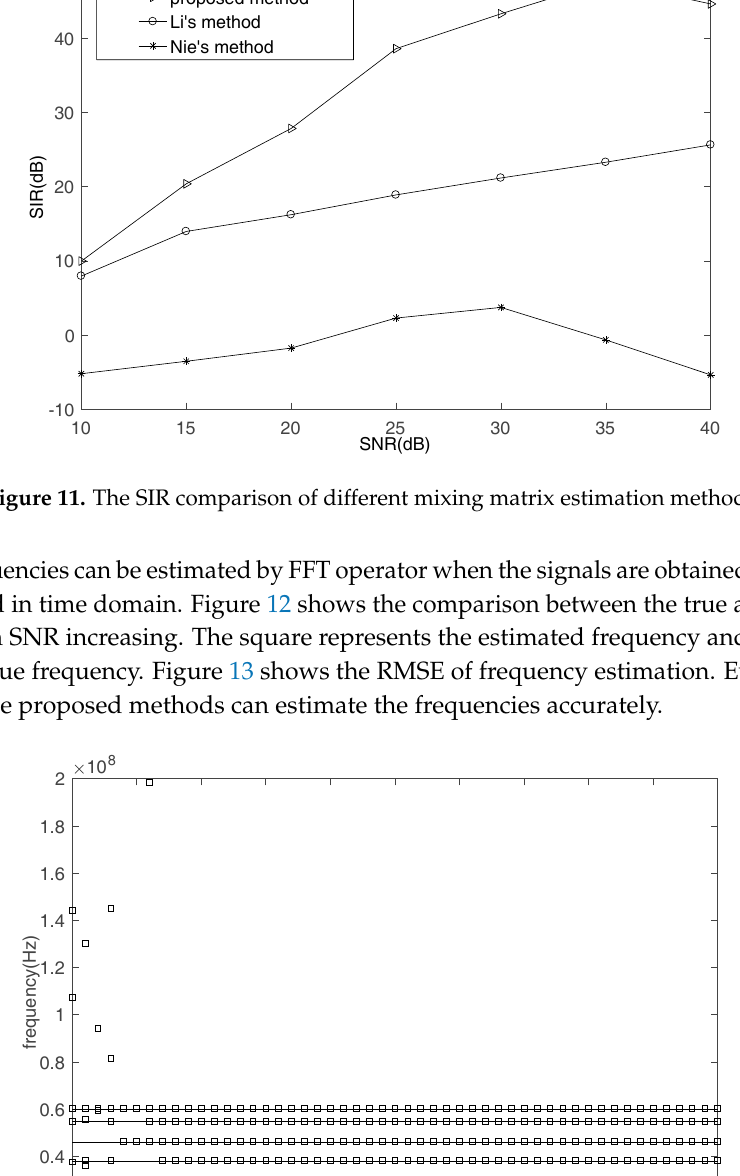
Figure 10. The SIR comparison of different recovered methods.